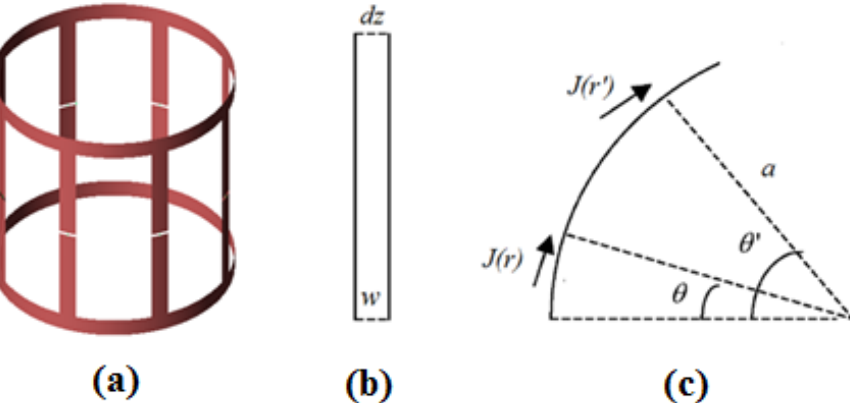
Figure 3. Lowpass birdcage coil (Coil #1): ( a ) CAD model for FDTD simulation; ( b ) lateral view of the birdcage end-ring strip segment; ( c ) upper side view of the birdcage end-ring strip segment.